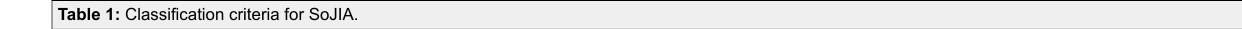
Table 1: Classification criteria for SoJIA. Arthritis with or preceding daily fever with a duration of at least 2 weeks accompanied by at least 1 of the following symptoms during the first 6 months. – Erythematous rash; – Lymphadenopathy; – Hepatomegaly and/or splenomegaly; –